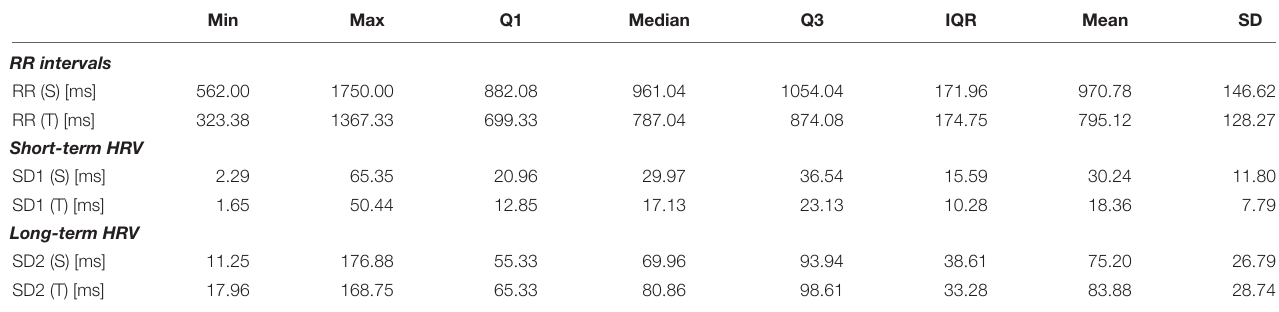
TABLE 1 | RR intervals and heart rate variability descriptors measured during 5 min in supine position (S) and 5 min in tilt (T).